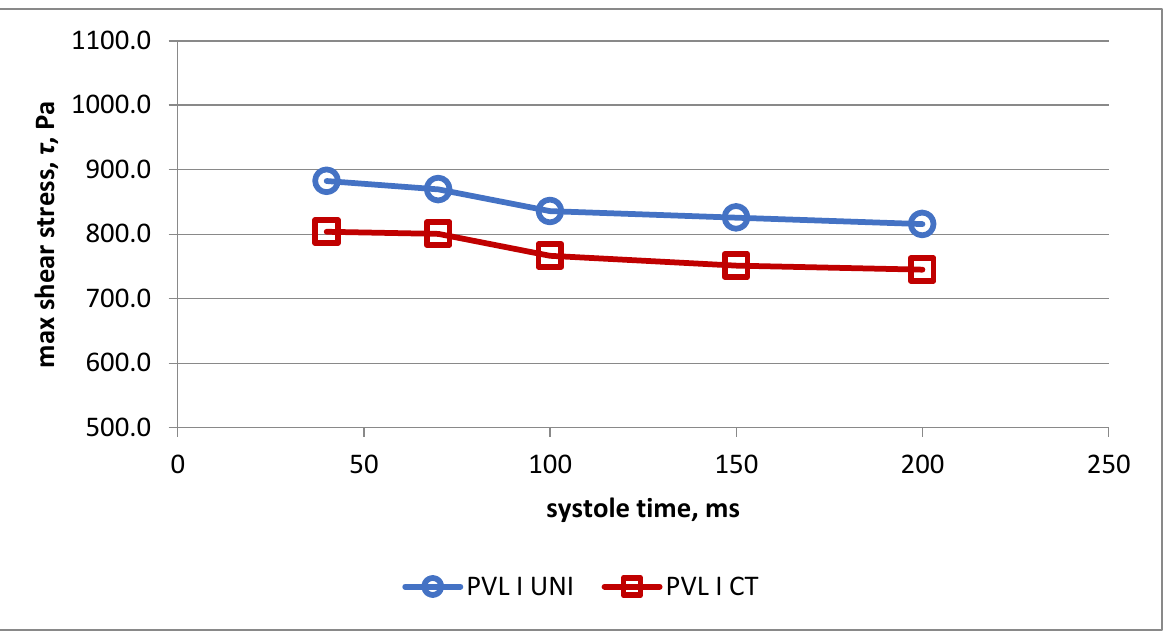
Figure 5. Values of maximal shear stress in fluid in universal model (UNI) and real-life model (CT) for PVL model I.